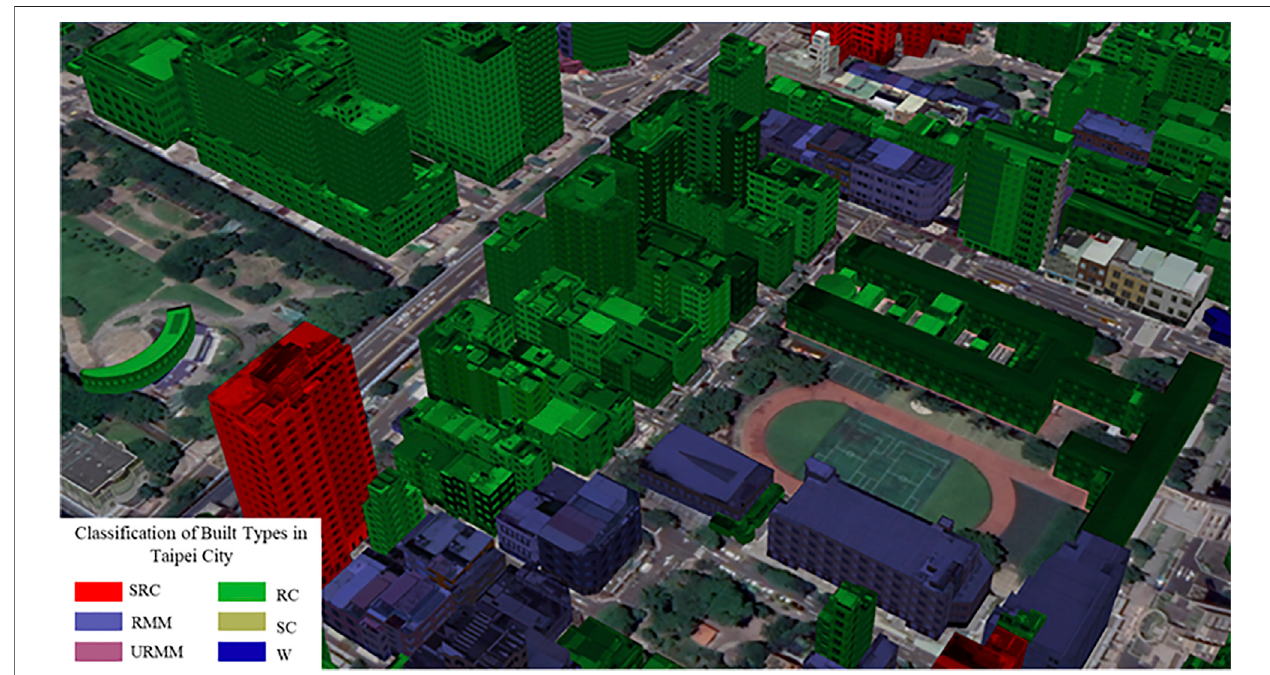
FIGURE 14 | Thematic map of buildings made of different materials in Taipei City.